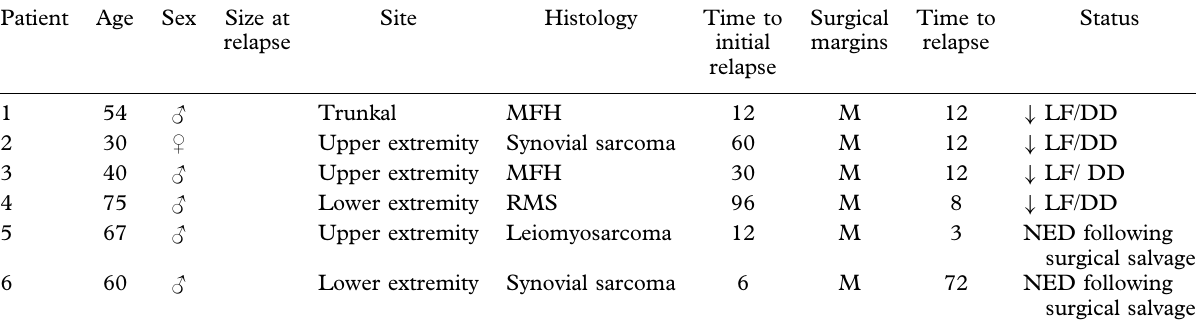
Table 3. Patients characteristics of local